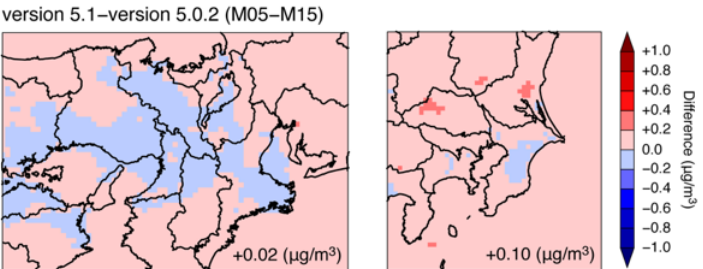
Figure 6. Spatial distributions of the difference caused by the model version between CMAQ versions 5.1 and 5.0.2 (M05 and M15) over (left) domain 3 and (right) domain 4. The value shown in the lower-right side indicates the spatially averaged difference.